Question: In a single sentence, describe what this figure presents.
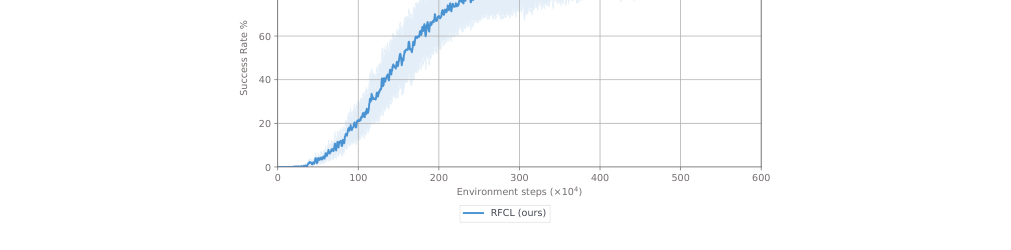
Answer: ManiSkill2 PegInsertion results with random demonstrations. Results averaged over 30 seeds with shaded area representing 95% CIs. The results appear much better than the main figures due to the noise caused by hard-to-learn-from demonstrations being mostly cancelled out. Here, only 1 out of the 30 seeds failed (the same seed from the main results that failed.